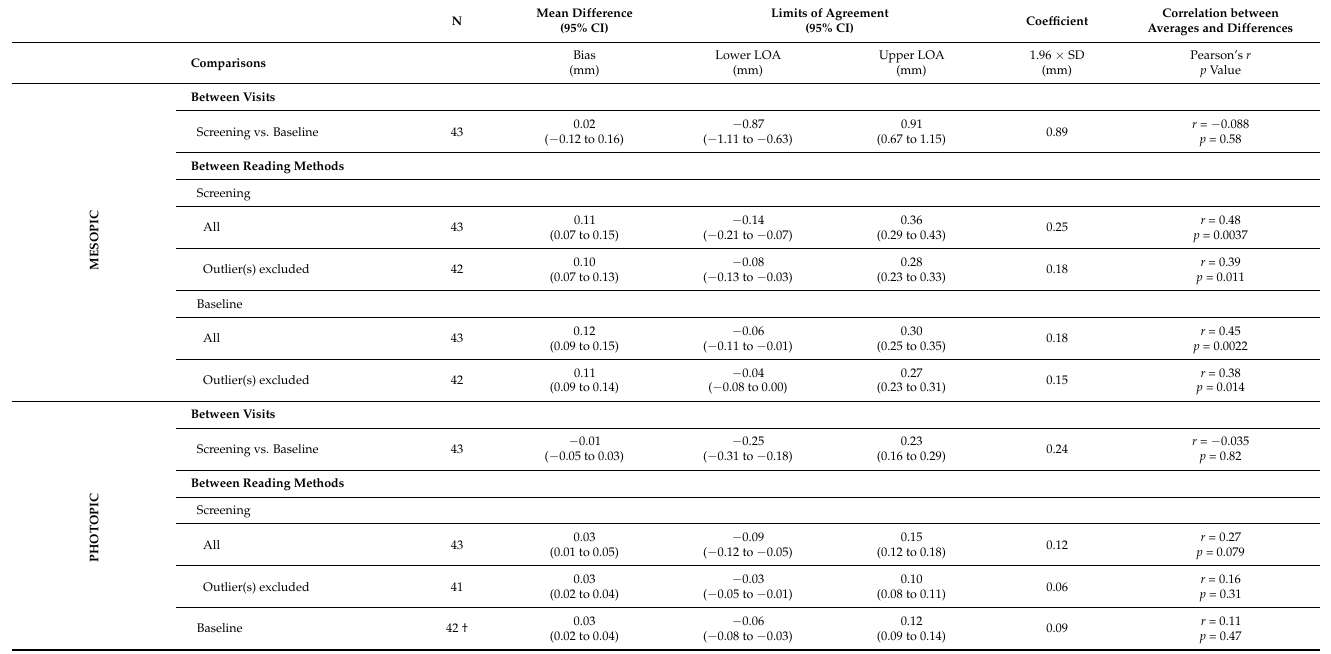
Table 2. Reproducibility of pupil size measurements between visits and reading